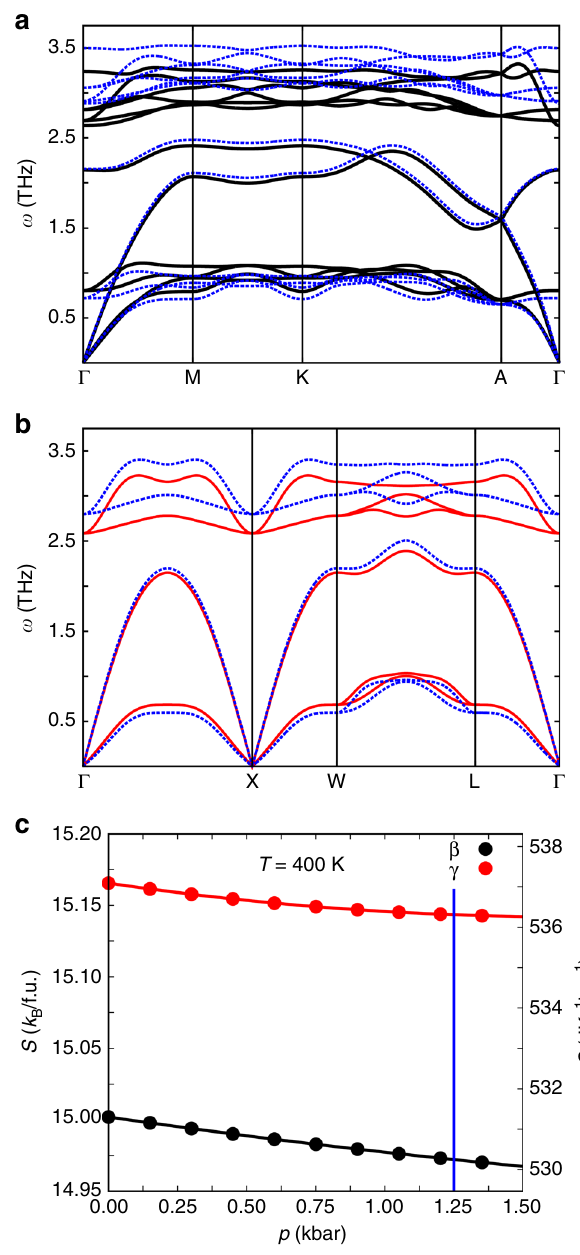
Fig. 2 First-principles calculations of AgI polymorph entropy. For the a β and b γ polymorphs in the β + γ phase, we show phonon dispersion spectra at the equilibrium volume (solid black and red), and on reducing the volume by 2% (dashed blue) ( ω denotes the angular frequency of vibration on passing between the labelled points of the Brillouin Zone). c Vibrational entropy S for the β (black) and γ (red) polymorphs at 400 K, normalized by formula unit (f.u., left axis) and mass (right axis). Experimentally, a pressure of 1.25 kbar drives the transition at 400 K (vertical blue